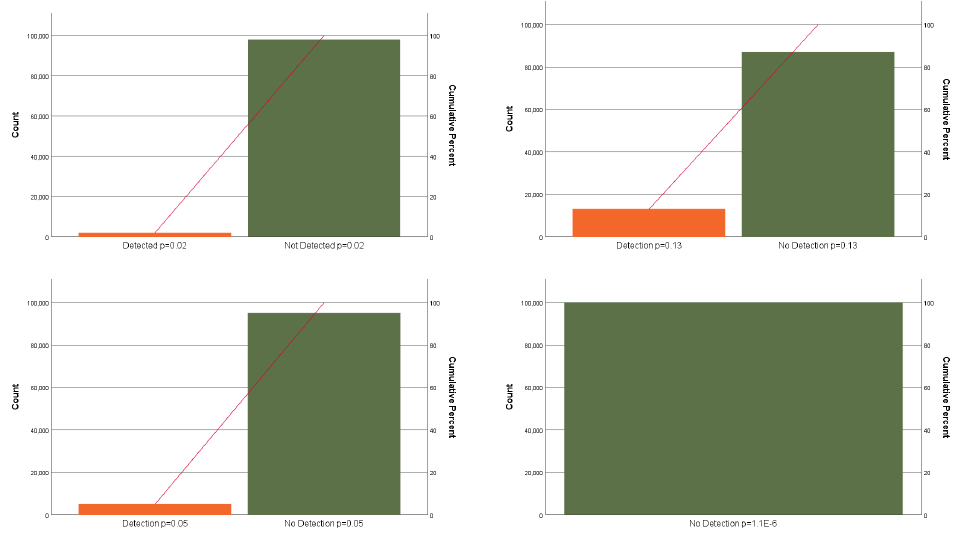
Figure 14. Pareto plots of Bernoulli samples of 100,000 based on the respective probabilities. Top left p = 0.02, top right p = 0.13, bottom left p = 0.05 (is also model average), and bottom right p = 1.1 × 10 − 6 .